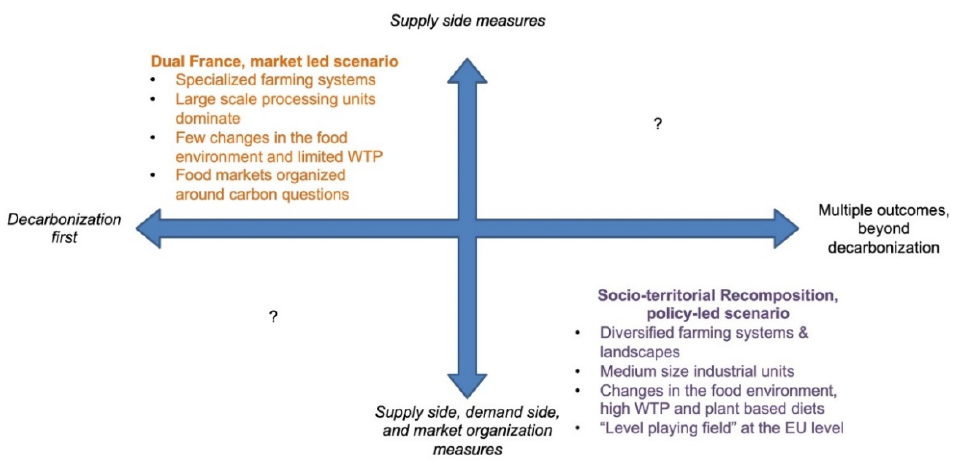
Figure 5. Transition space and positioning of the two scenarios